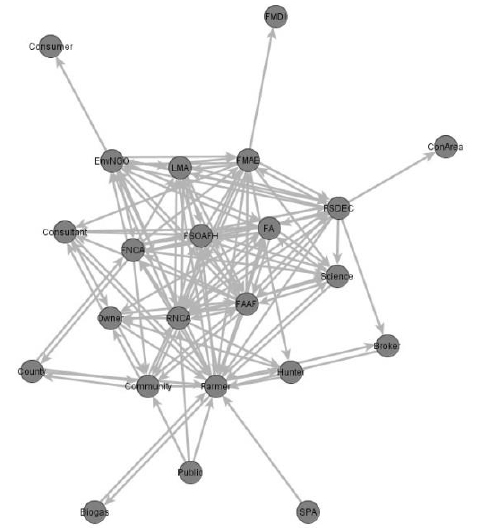
Figure A2.3. Regional network when four and more links between actors were